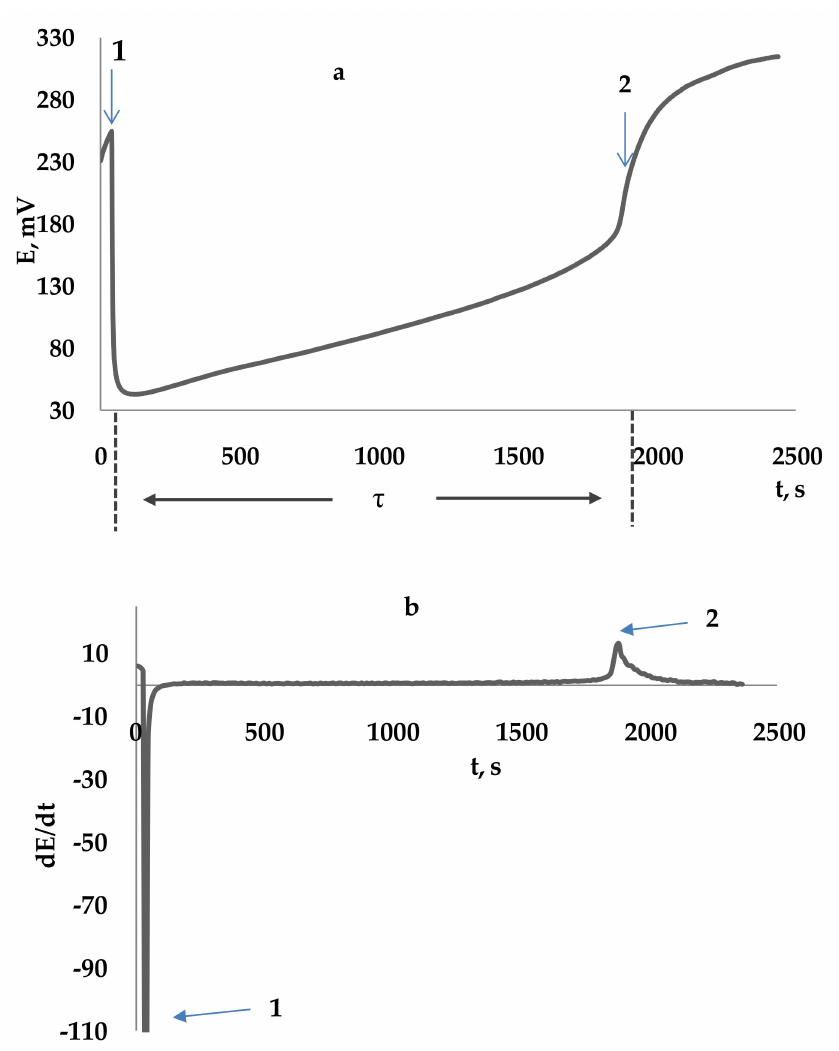
Figure 6. The kinetic curve of the potential change ( a ) and the derivative of the potential dependence on time ( b ): 1—0.1 M AAPH; 2—the addition of ascorbic acid (C = 0.3 mM) to 0.1 M